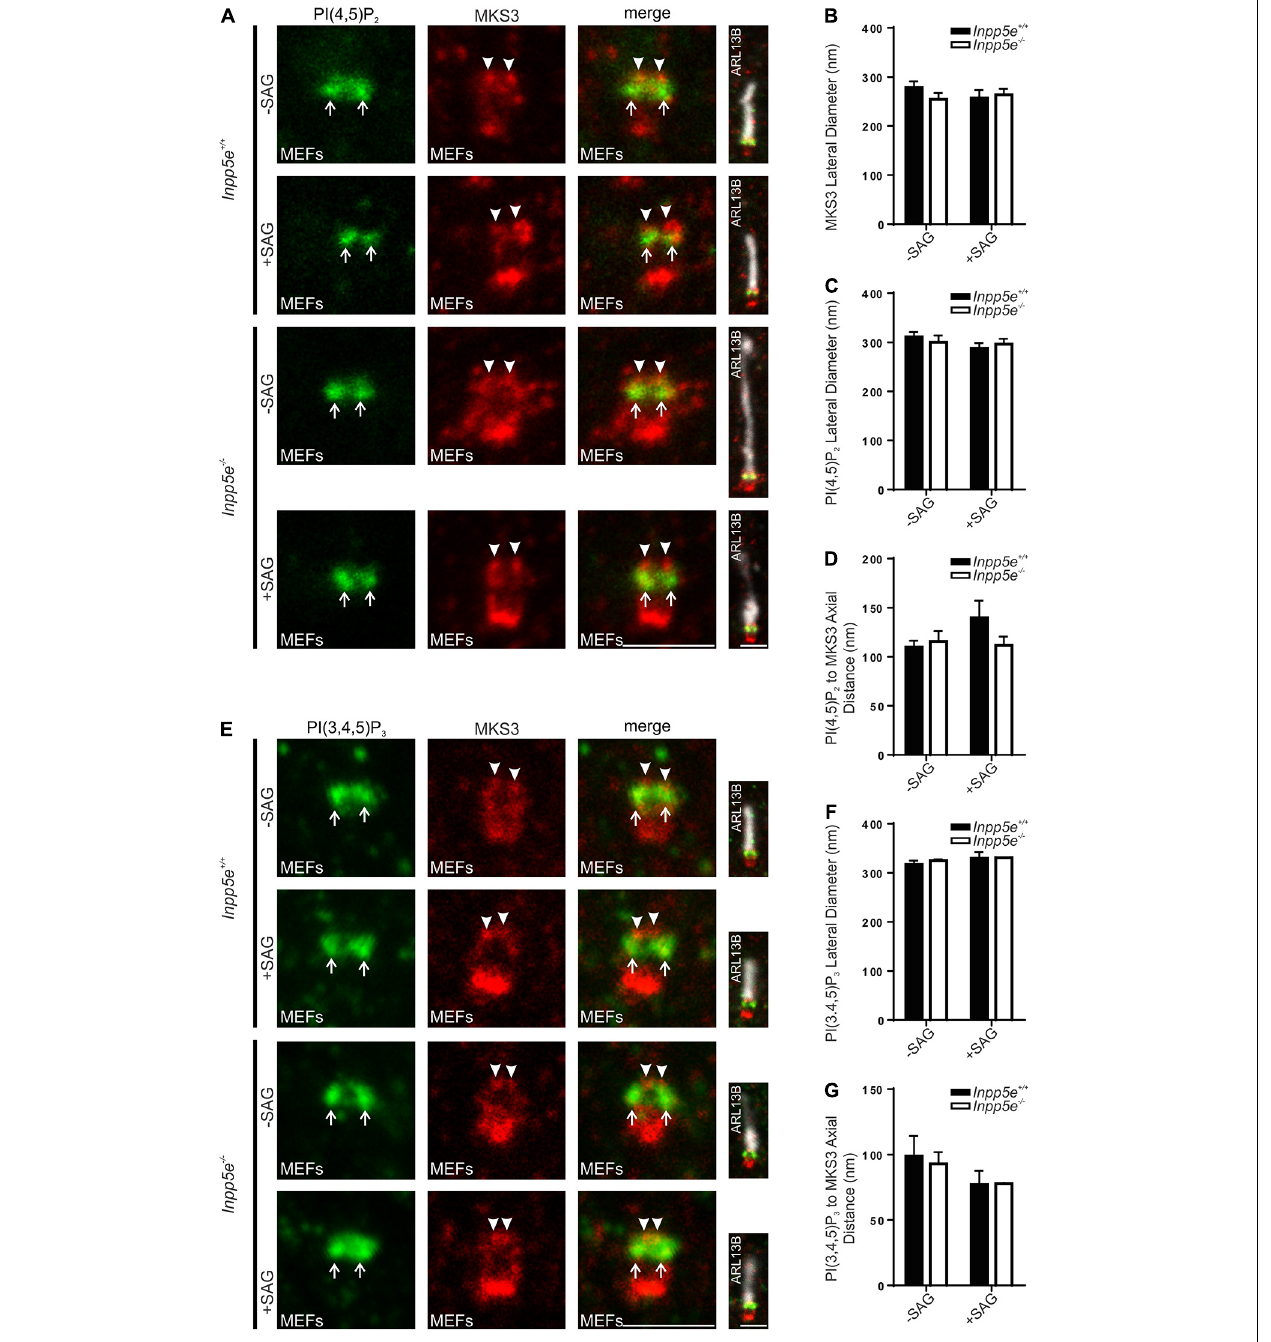
FIGURE 5 | Transition zone phosphoinositide subdomain localization is not altered by stimulation or loss of a regulatory 5-phosphatase, INPP5E. (A–G) Ciliated Inpp 5 e + / + and Inpp5e − / − MEFs cells were treated + /- 100 nM SAG and immunostained with (A) PI(4,5)P 2 or (E) PI(3,4,5)P 3 (green), MKS3 (red) and ARL13B (grayscale) antibodies and imaged by STED microscopy (confocal resolution image of the ARL13B stained axoneme is shown). Right panels show merged image at lower magnification. Arrows indicate transition zone PI signals, arrow heads indicate MSK3 localization, bar indicates 1 µ m. Graph shows the lateral diameter between the highest intensity points of the (B) MKS3, (C) PI(4,5)P 2 or (F) PI(3,4,5)P 3 puncta perpendicular to the plane of the axoneme. Bars represent mean ± SEM, n = 3 independent experiments, 30 cilia imaged per experiment and all cilia with two distinct PI or transition zone protein puncta measured. Graph shows the axial distance between the highest intensity point of the (D) PI(4,5)P 2 or (G) PI(3,4,5)P 3 signal and the MKS3 signal parallel to the plane of the axoneme. Bars represent mean ± SEM, n = 3 ( n = 2 for SAG treated Inpp5e − / − cells) independent experiments, 30 cilia imaged per experiment and all cilia with distinct PI or MKS3 puncta